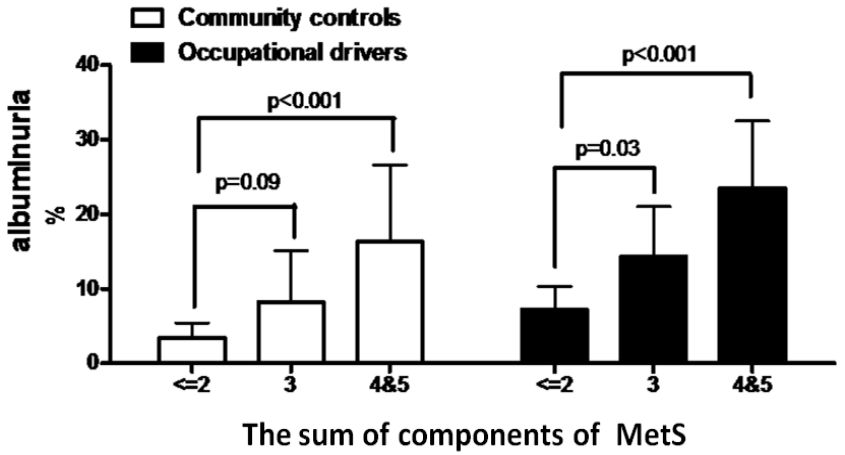
Figure 2. Prevalence of albuminuria according to the sum of components of metabolic syndrome in occupational drivers and community control.